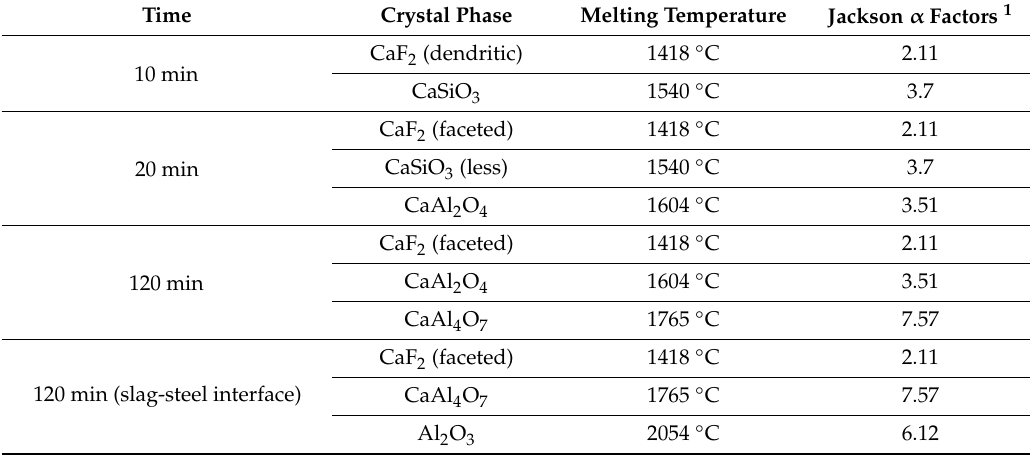
Table 3. Typical crystals of slag sample B and corresponding Jackson α factors, wt.%.